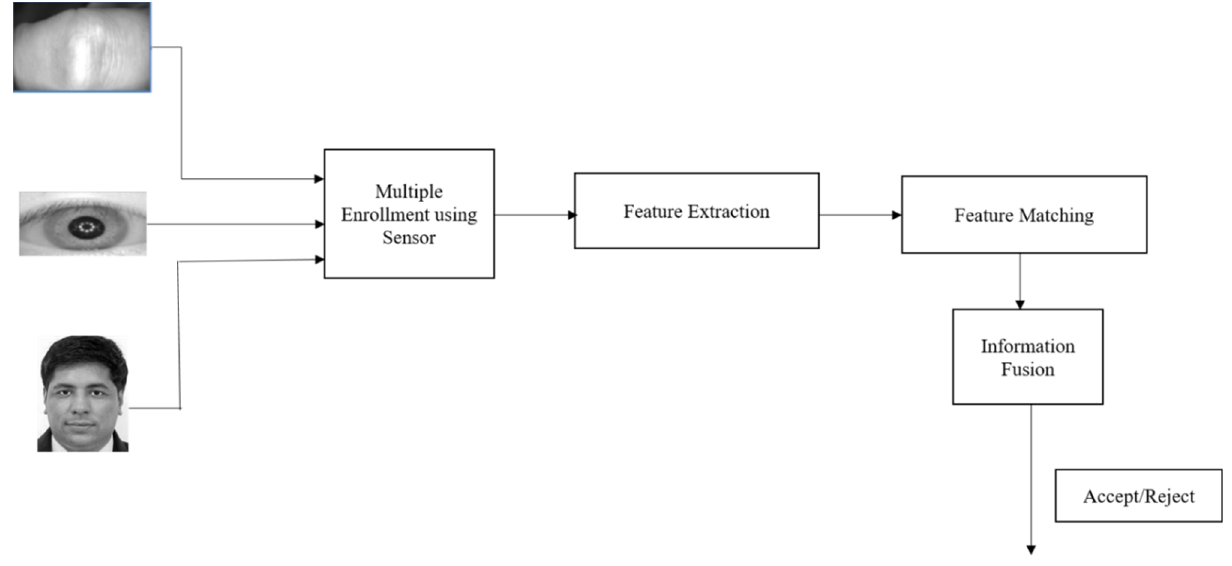
Figure 1. Multimodal biometric system.